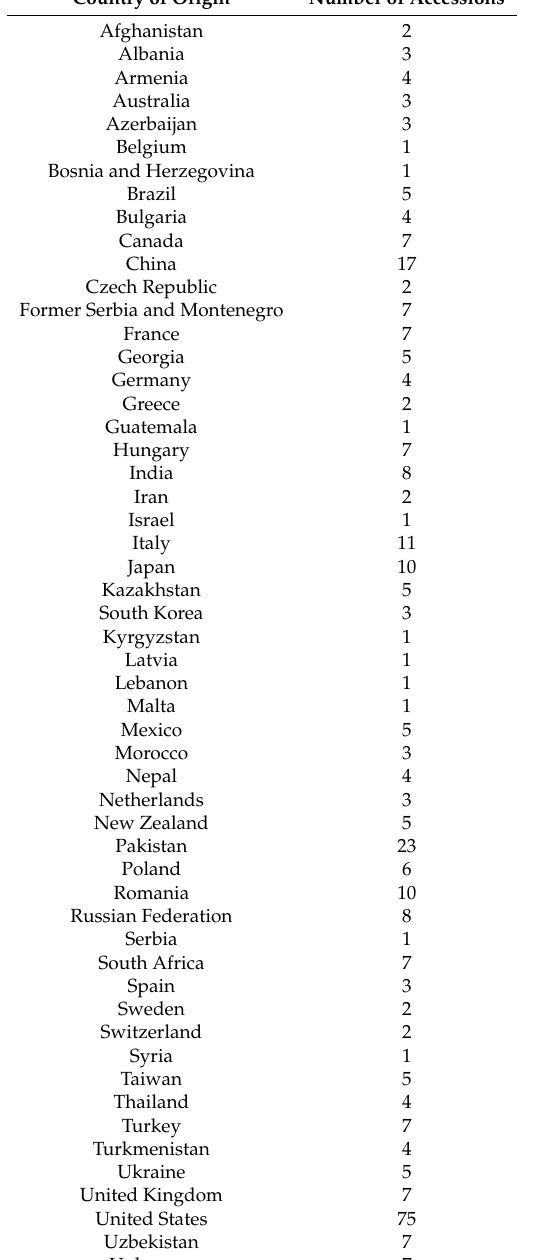
Table 6. Prunus accessions included in the survey and corresponding country of